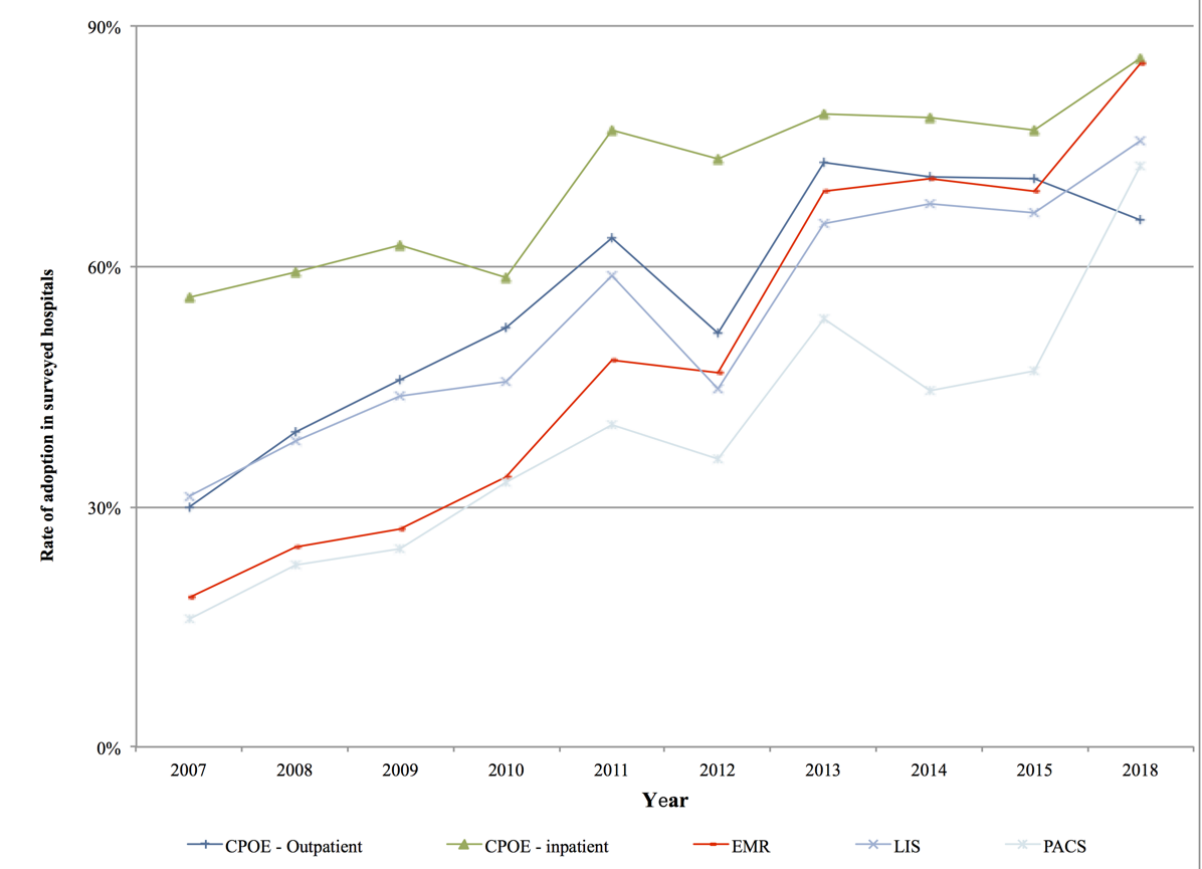
Figure 10. Application and implementation of computerized prescriber order entry, electronic medical record, laboratory information system, and picture archiving and communication system in the sampled hospitals from 2007 to 2018. CPOE: computerized prescriber order entry; EMR: electronic medical record; LIS: laboratory information system; PACS: picture archiving and communication system. (Note: Due to a change in the leadership of